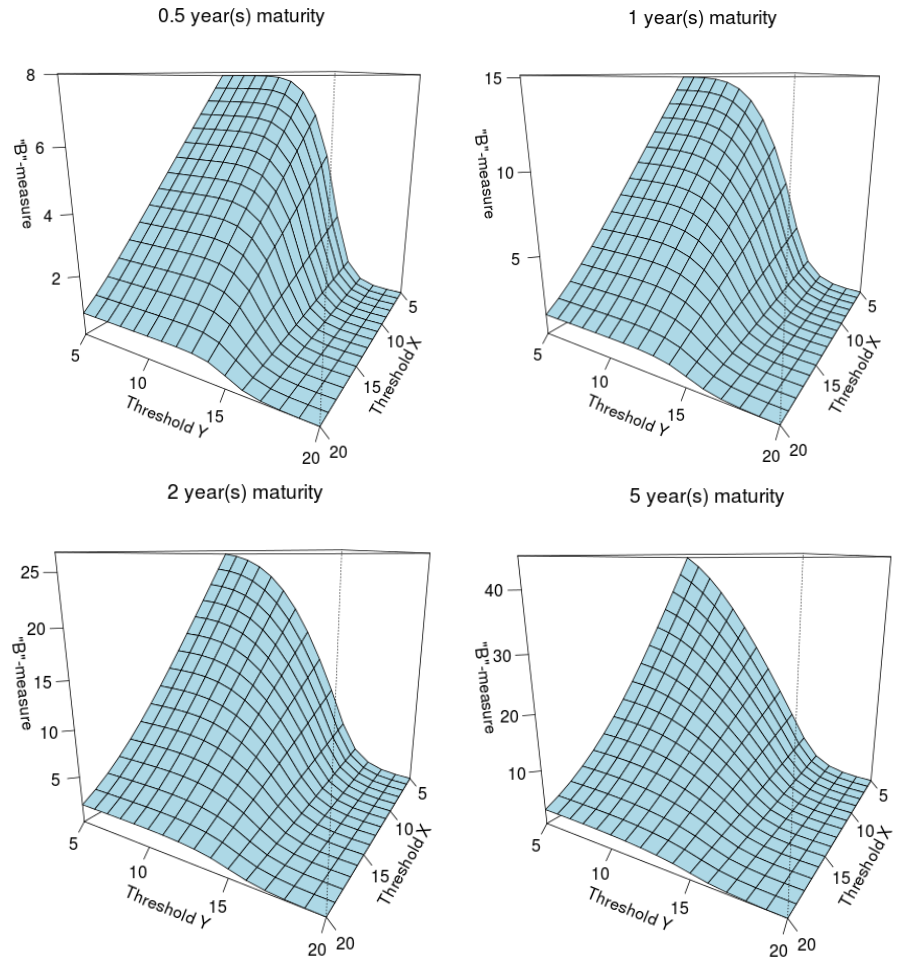
Figure 5. B-measure for the Model described in Subsection (3.1) with initial temperature equal to 15 ◦ C for the minimal temperature and 22 ◦ C for maximum temperature and maturity time equal to six months (at the top-left corner), one year (at the top-right corner), two years (at the bottom-left corner) and five years (at the bottom-right corner). B-measure is plotted as a function of both the threshold of the minimum temperature (from 5 ◦ C to 20 ◦ C) and the maximum temperature (from 5 ◦ C to 20 ◦